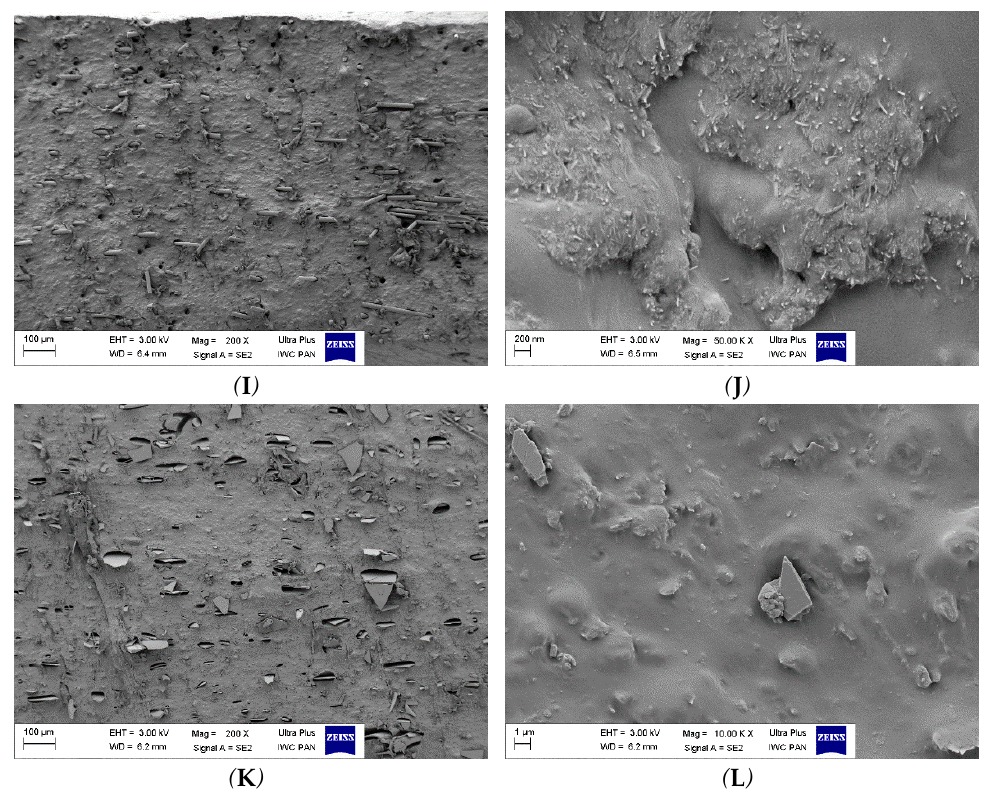
Figure 2. SEM photos of EPDM rubber composites. ( A , B )—graphene flakes; ( C , D )—carbon nanotubes; ( E , F )—basalt fibers (BFS); ( G , H )—basalt flakes (BFL); ( I , J )—BFS and CNTs; ( K , L )— graphene flakes and BFL.